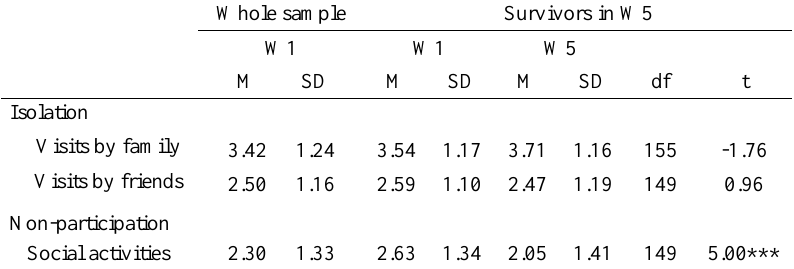
Table 2 . Isolation and non-participation in W 1 (n = 295 ) and changes be- tween W 1 and W 5 (n = 157